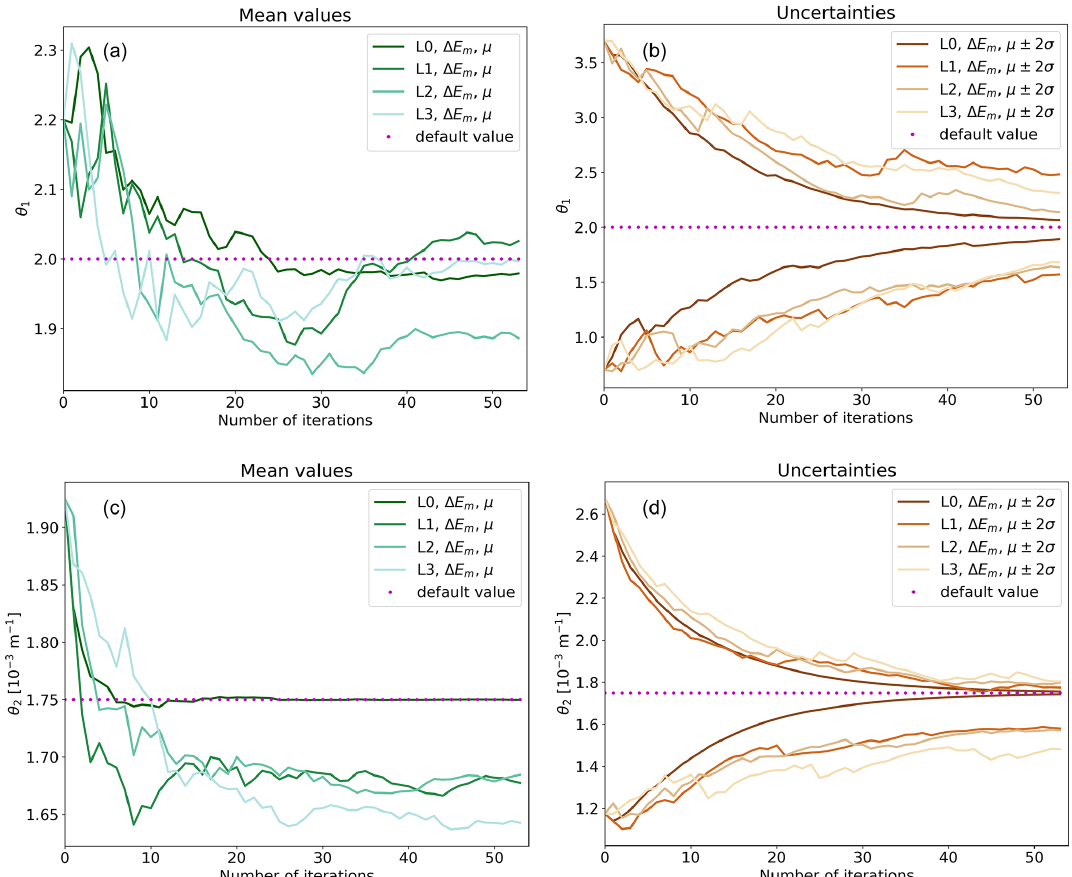
Figure 1. Comparison of convergence tests at different levels of complexity. Panels (a) and (b) show the evolution of distribution mean value ( µ ) and the mean value ± 2 standard deviations of uncertainty ( µ ± 2 σ ) for θ 1 , and panels (c) and (d) show the same as (a) and (b) but for θ 2 . The purple dots show the parameter default values. The x axes show running number of iterations, i.e. how many ensemble forecasts have been used. (cid:49)E m is used as the cost function, and the levels of complexity are summarised in Table 2. EPPES is used as the optimiser, the ensemble size is 50 members, and the forecast range is